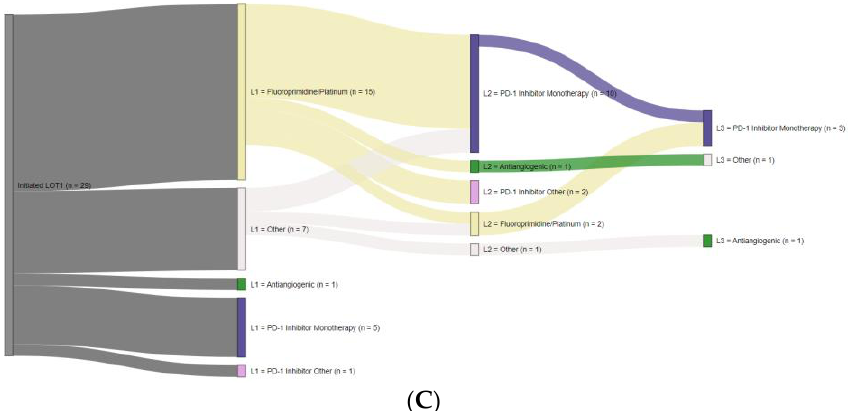
Figure 4. Sankey diagrams for treatment sequences. Patients whose only regimen was weekly carboplatin and paclitaxel are not included in Sankey diagrams. L1, first-line. L2, second-line. L3, third-line. LOT, line of therapy. MSI, microsatellite instability. MMR, mismatch repair. n, number of patients tested. PD-1, programmed death receptor-1. PD-L1, programmed cell death-ligand